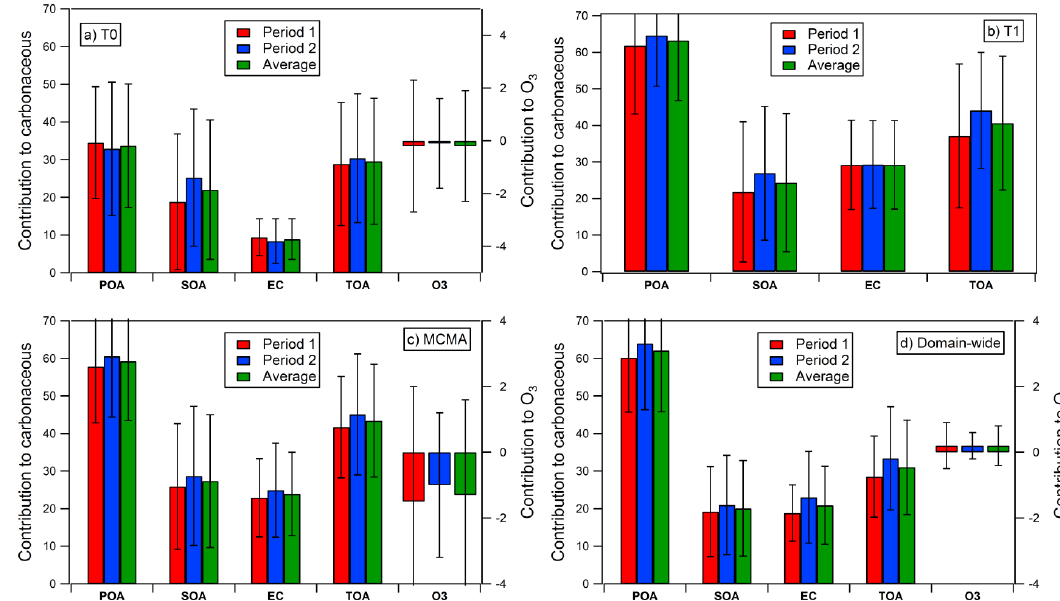
Fig. 10. Simulated BB impacts on O 3 , OA and EC at different locations. (a) T0, except the O 3 concentrations are averaged over the RAMA stations, most of which are located in the MCMA urban area. (b) T1, (c) MCMA, and (d) domain-wide. The error bars in the figure represent the standard